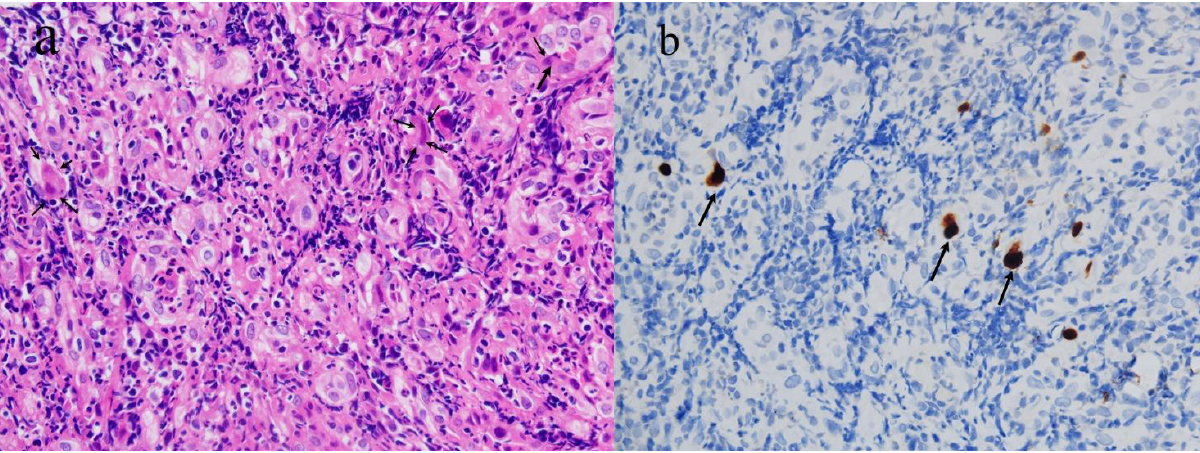
Figure 2. ( a ) Microscopic examination of rectal biopsy (×400, H&E stain). The large, infected cell showed an intranuclear viral inclusion with a perinuclear halo. ( b ) Immunohistochemical staining with monoclonal antibodies for CMV (×400) demonstrated positive uptake in inclusion bodies (ar-